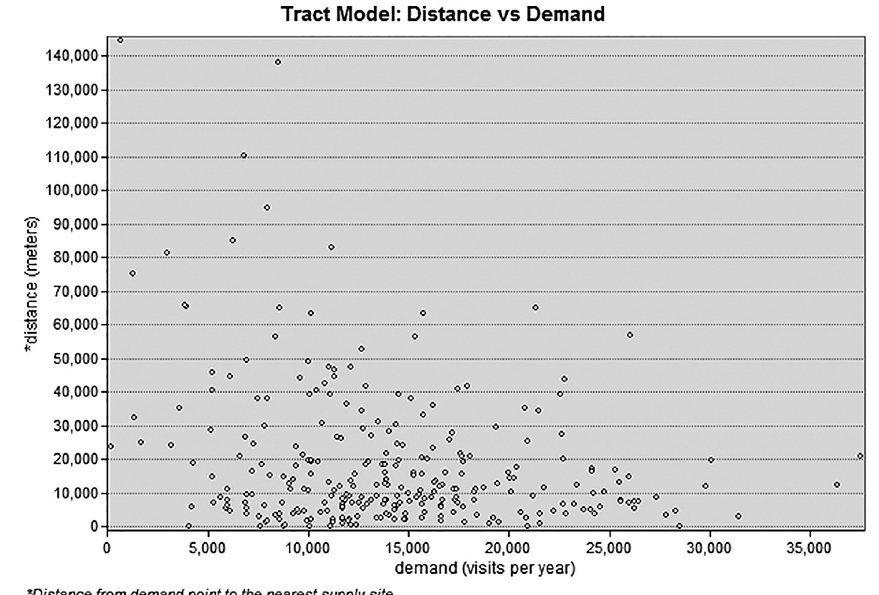
Fig. 2. Tract model: distance vs. demand